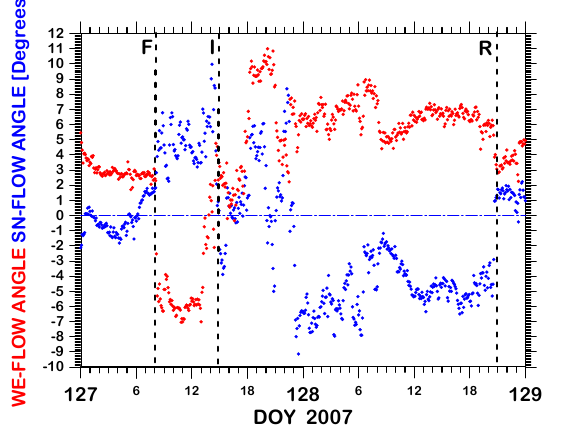
Fig. 2. (Same format as Fig. 1) Flow angles of iron ions near the CIR of 18/19 May 2007. The WE-aberration has not been corrected. This CIR has not yet developed shocks at the site of the spacecraft near 1AU. Correspondingly, the transitions near the forward and reverse pressure waves, “F” and “R”, are smoother than in the ex- ample shown in Fig.